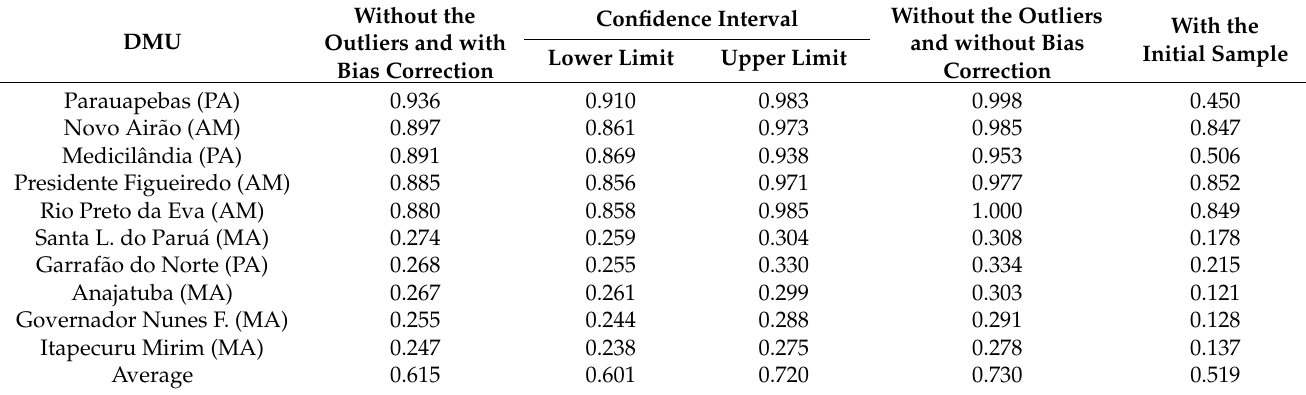
Confidence Interval Without the Outliers